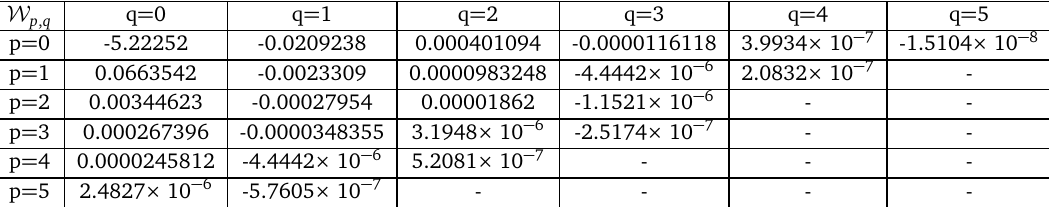
Table 2: W for 1-loop φ 4 p , q